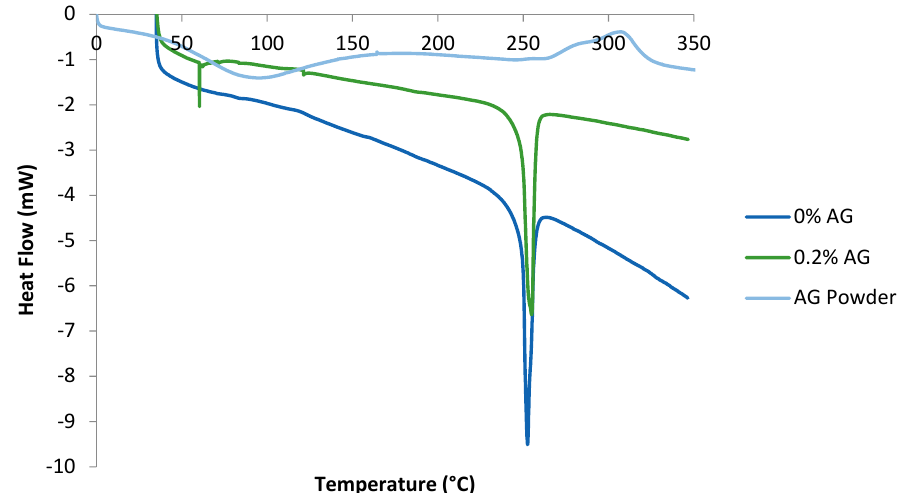
Figure 5. Thermograms of plain PA membrane (0% AG), PA/0.2 wt.% AG membrane and AG powder.